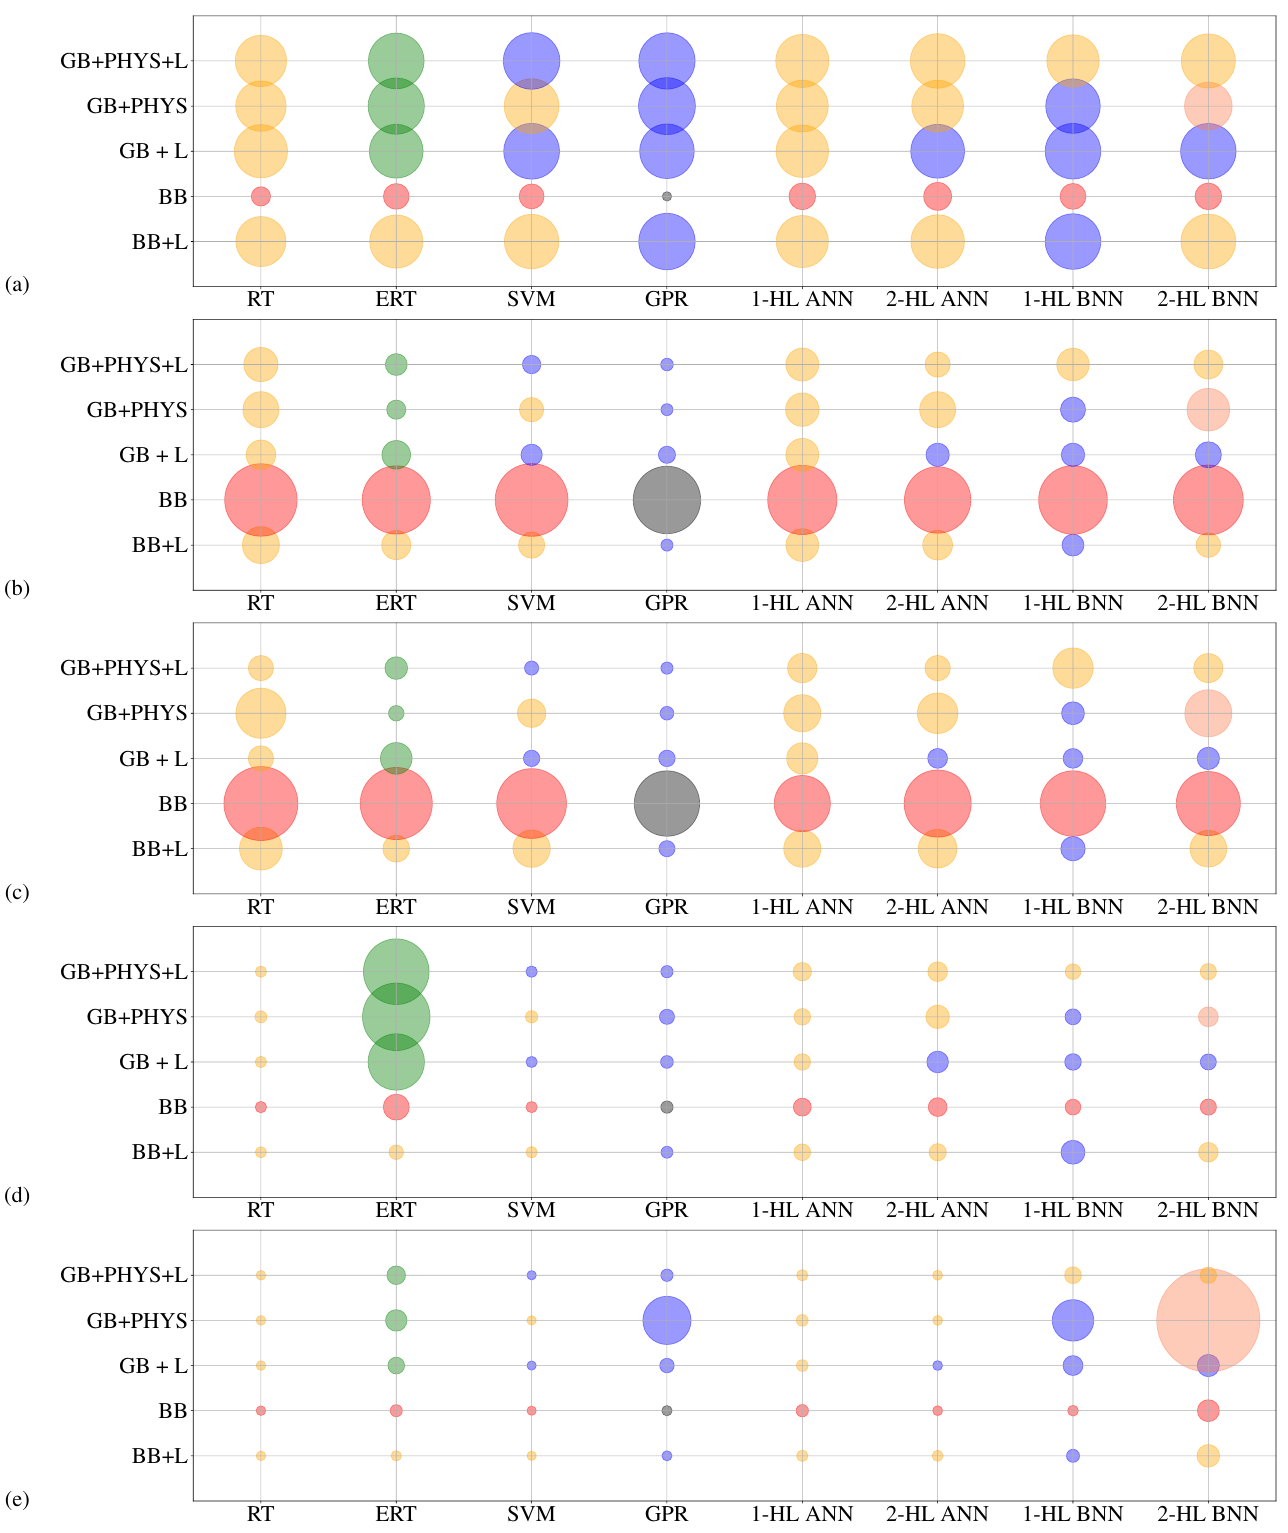
[ mg/m 3 ] , ( d ) t test [ ms ] (test time), and ( e ) t E test,max | |